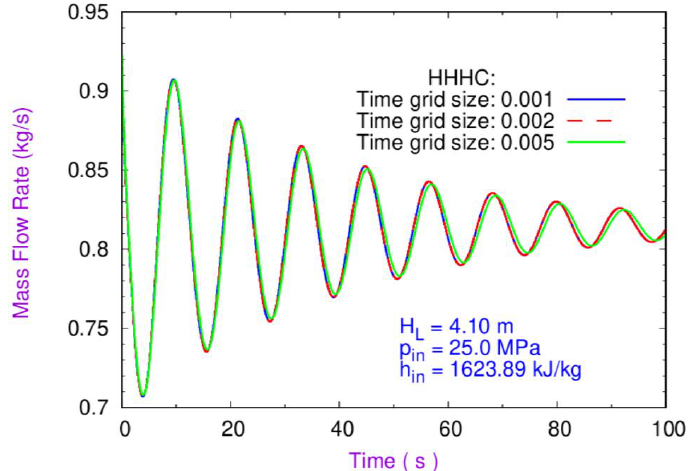
Figure 3. Fluctuation of mass flow rate with respect to time for three different time steps.